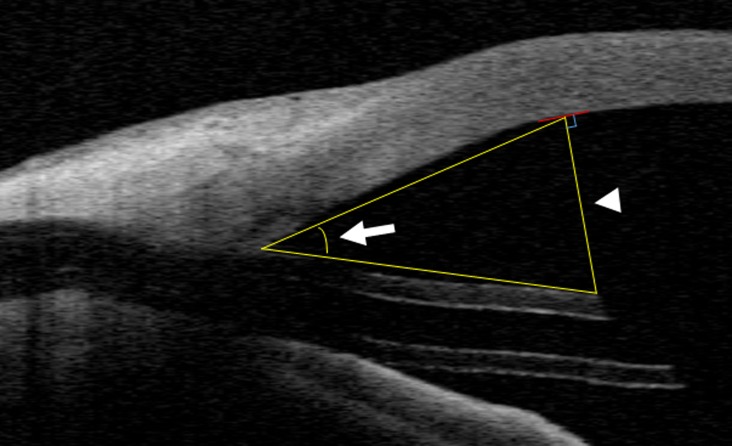
AS-OCT image of eyes with anterior chamber BGI.AS-OCT shows the tube of the Baerveldt glaucoma implant (BGI), the tube–cornea angle (arrow), and the tube–cornea distance (arrowhead).